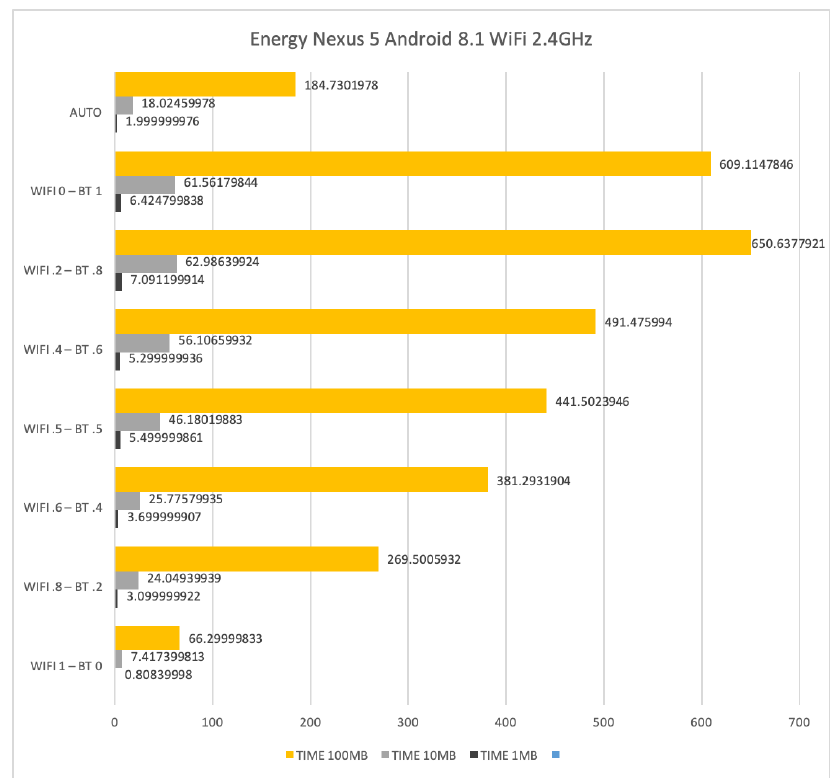
Figure 16. Time required for transferring files of size 1 Mb, 10 Mb and 100 Mb by means of WiFi at 2.4 GHz and Bluetooth on a LG Nexus 5 with Android 8.1.